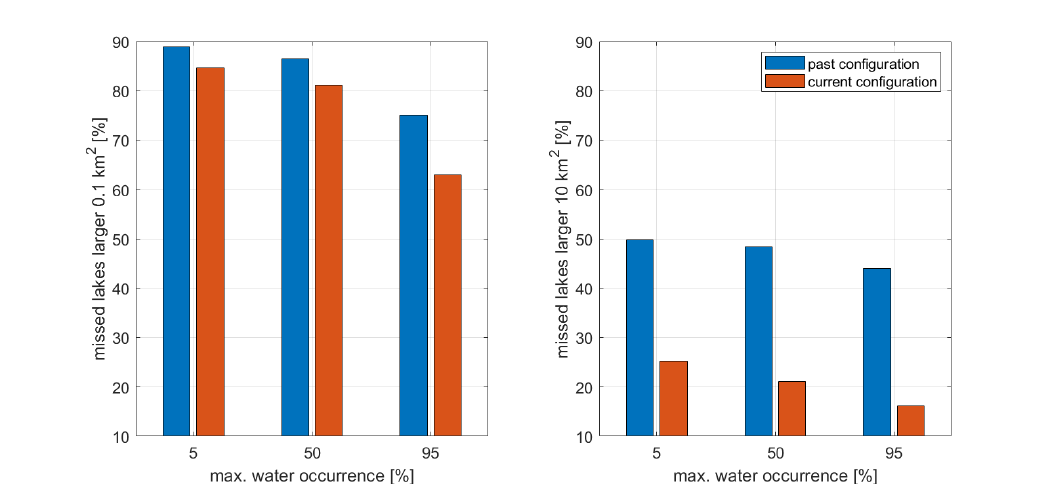
Figure 8. Percentage of missed lakes/reservoirs for different altimetry configurations and different water occurrences. Left: all water bodies larger than 0.1 km 2 ; right: water bodies larger than 10 km 2